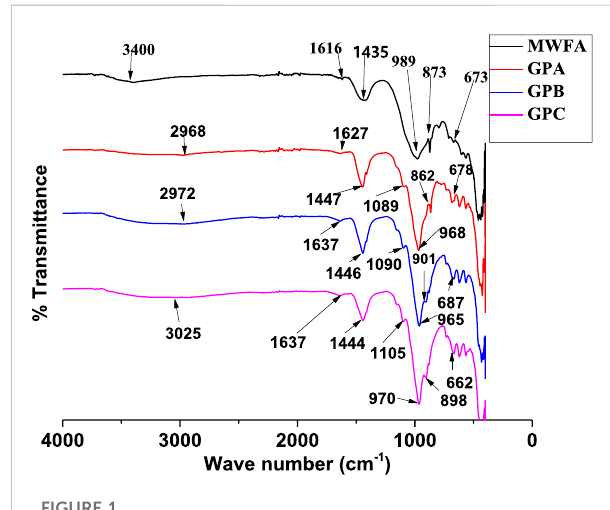
FIGURE 1 FTIRspectraofMWFAandMWFA-basedgeopolymersGPA,GPB, and